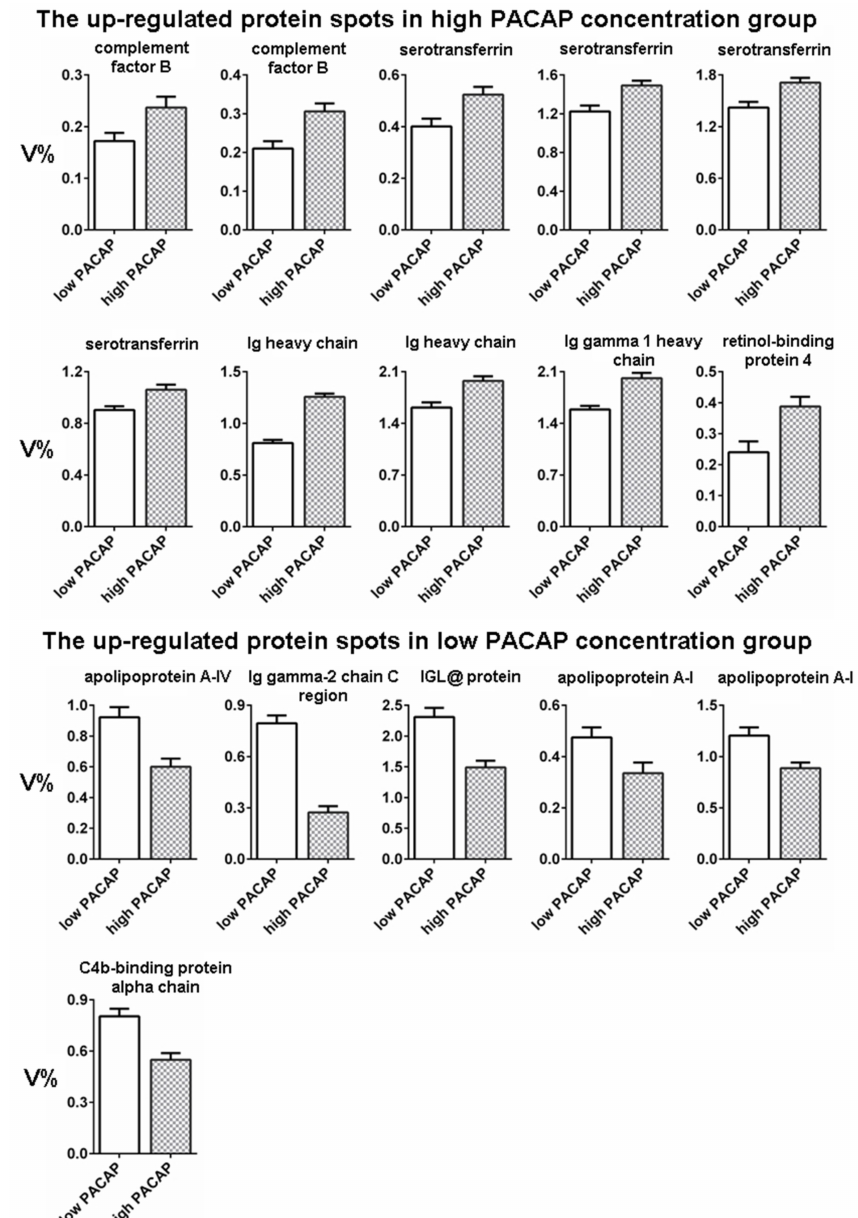
Figure 3. Normalized volumes (V%) of spots with statistically significant ( p < 0.05) intensity dif- ference between the low − and high − PACAP (pituitary adenylate cyclase-activating polypeptide) − concentration groups. Data are presented as mean ±